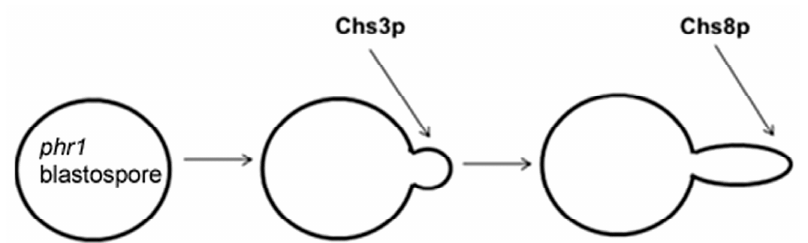
Figure 10. Model of the sequential involvement of the chitin synthases in the adaptation to cell wall stress of a phr1 cell during induction of hyphal growth in M199 at a restrictive pH. First, at the time of germ tube emergence Chs3p is crucial in liquid media and, if not present, phr1 Δ cells arrest at early germ tube emergence, swell and die. On solid surface, Chs3p is crucial for the onset of germination and if absent phr1 Δ cells do not produce colonies. Chs8p is crucial for the development of the germ tube. Once the germ tube has emerged, Chs8p acts to protect the tip. If Chs8p is absent during growth on a solid medium, phr1 Δ cells give rise to abortive microcolonies containing dead cells.